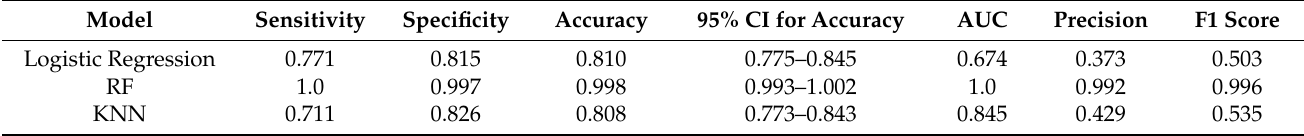
Table 3. Performance of suicide risk prediction.